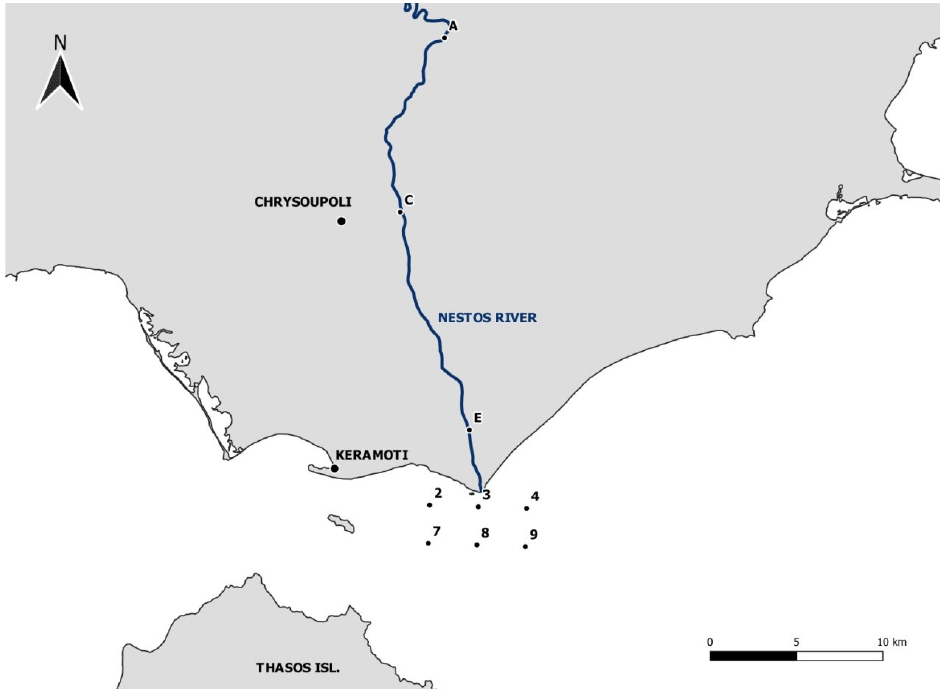
Figure 1. Map of study area indicating the positions of water and sediment sampling across the river, in the deltaic area, and in the sea.